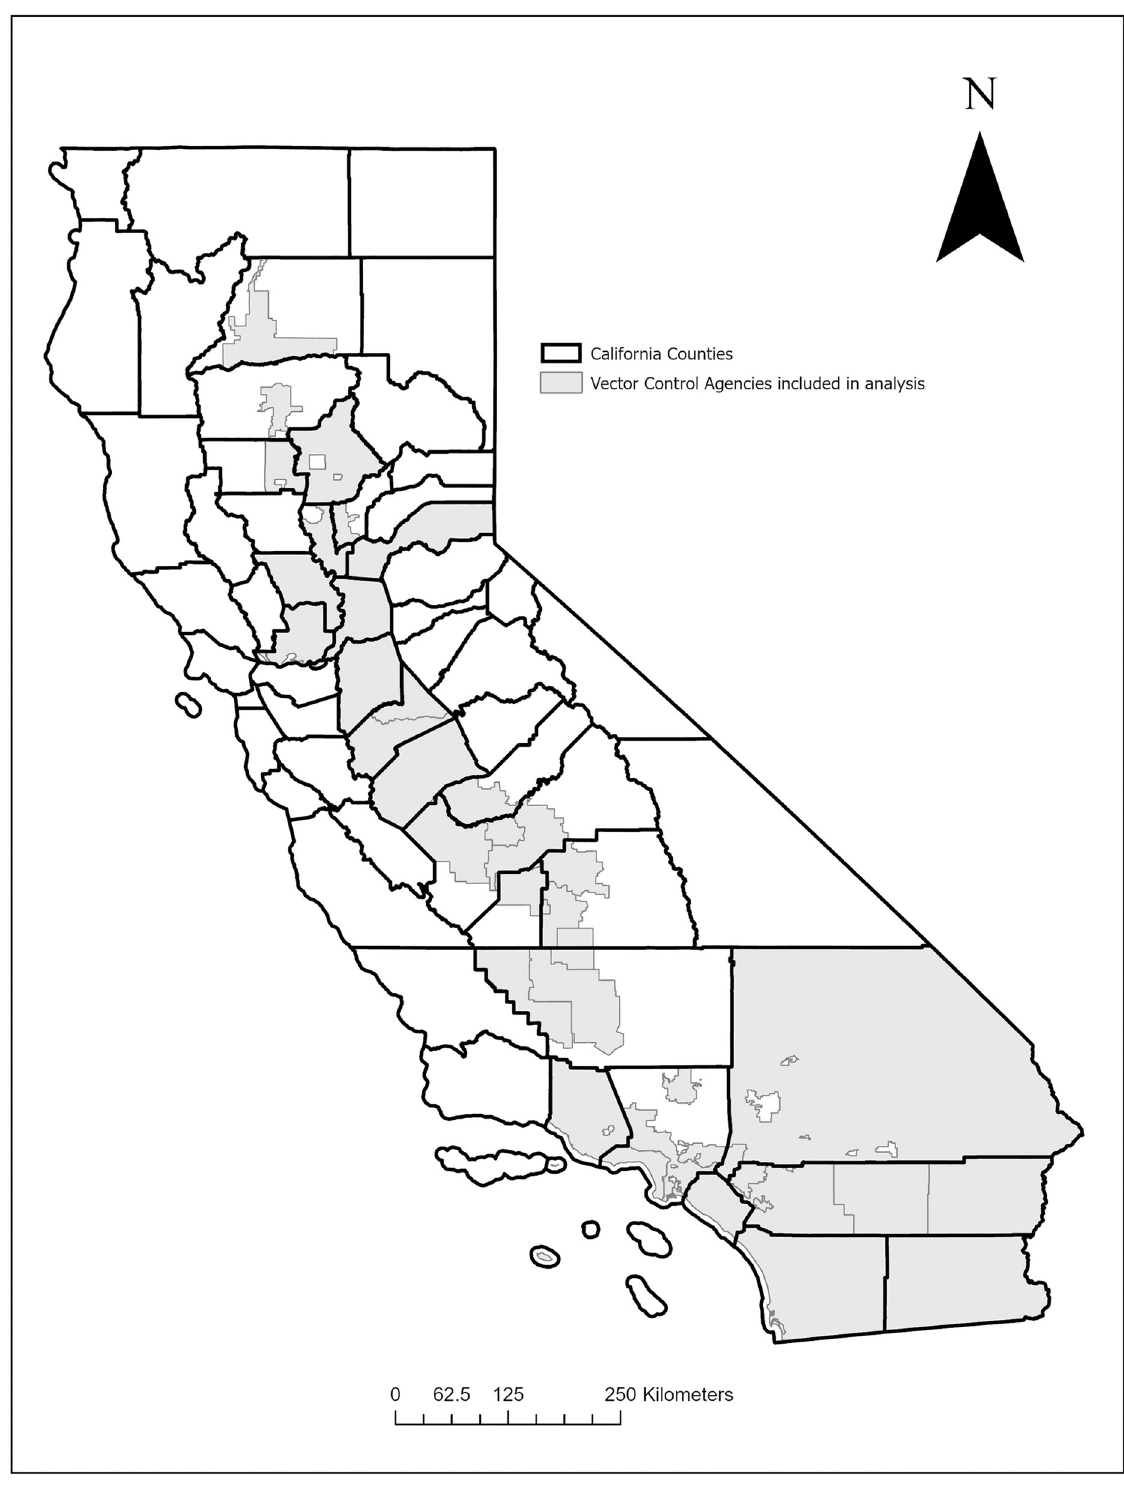
Fig 1. Map of California vector control agencies and counties included in analysis of effectiveness of vector index and California Response Plan, CA, 2009–2018. County data courtesy of U.S. Census Bureau TIGER/line spatial files, 2016 (https://www.census.gov/ geographies/mapping-files/time-series/geo/tiger-line-file.2016.html). Vector control agency data courtesy of Mosquito and Vector Control Association of California web map, 2018, (sources: ESRI, USGS, NOAA, TomTom, U.S. Department of Commerce, U.S. Census Bureau, NPS). (https://www.arcgis.com/apps/mapviewer/index.html?webmap=604a0fe9f2b74e98a53b53d192b2ac67).